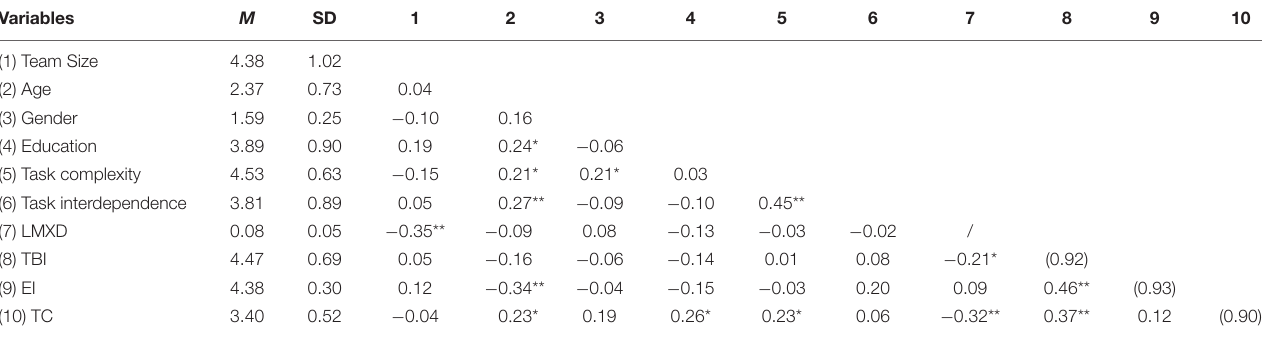
TABLE 2 | Means, standard deviations, and correlations among variables.